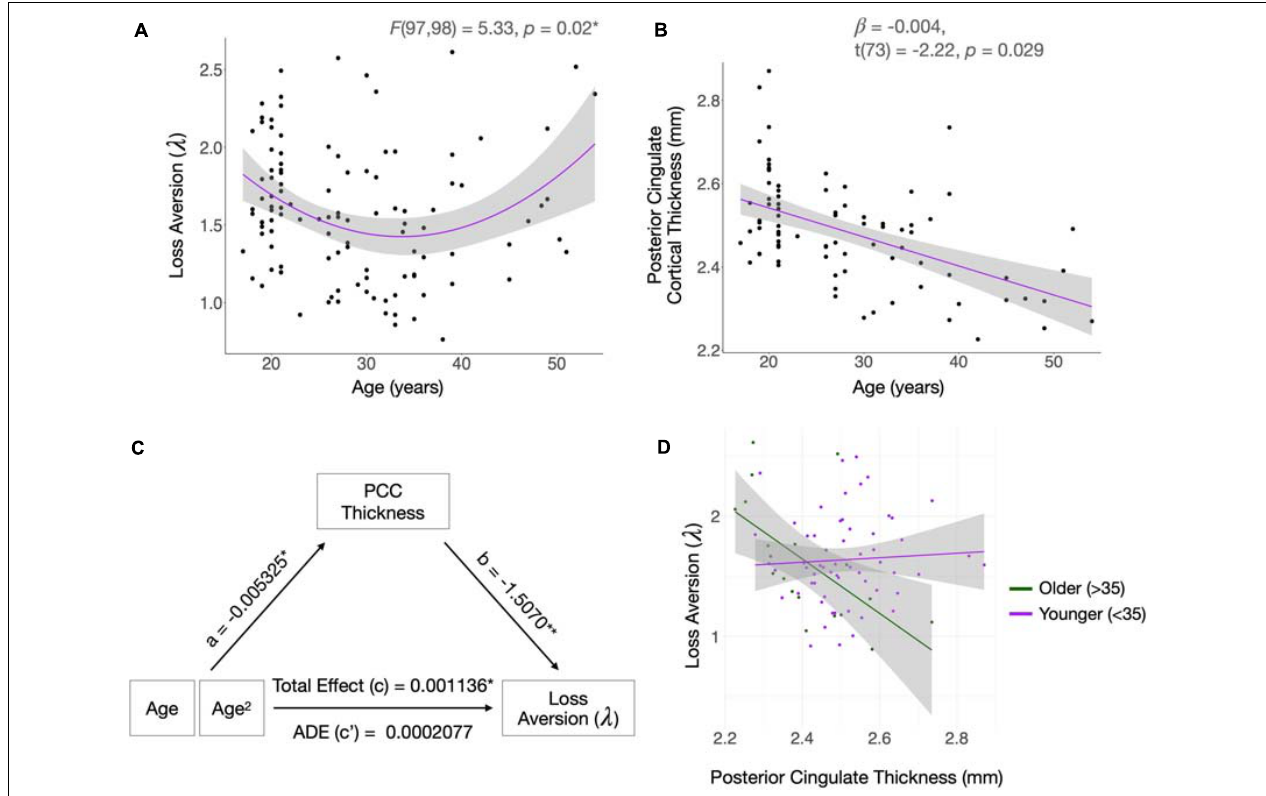
FIGURE 2 | Relationships between age, loss aversion, and cortical thickness. (A,B) Loss aversion ( λ ) follows a quadratic trajectory with age, whereas cortical thickness of the posterior cingulate cortex (PCC) declines linearly with time. Shading indicates standard error confidence intervals. (C) Cortical thickness of the PCC mediates age-related changes in λ . The effect of age on PCC thickness is given by “a.” The effect of PCC thickness on λ is given by “b.” The Average Direct Effect (ADE; “c”) is the effect of age on λ when controlling for the mediator of PCC thickness. To calculate the Total Effect (c) of age on λ , without accounting for the mediator, both age and age 2 were included in the model and the regression coefficient for age 2 was taken as the strength of the effect. The causal mediation analysis was performed using nonparametric bootstrap confidence intervals and Monte Carlo simulations. The model included age, age 2 , race/ethnicity, scanner, and estimated intracranial volume, as well as PCC thickness as the mediator. Age 2 was specified as the variable of interest. The measure of significance was given by the Average Causal Mediation Effect (ACME; p = 0.018*). Asterisks denote statistically significant results. * p < 0.05, ** p < 0.01. (D) A negative relationship between PCC thickness and λ exists in older participants, but no relationship is present in participants under 35 years. The age of 35 was used to split the data into younger and older groups as it approximates the inflection point of the age- λ